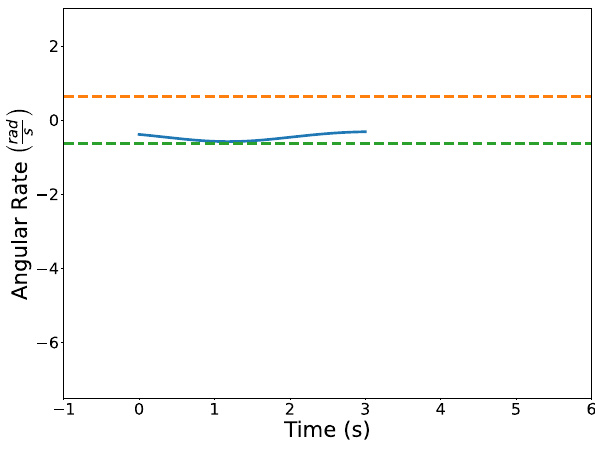
Figure 32. Squared speed profile of the vehicle.